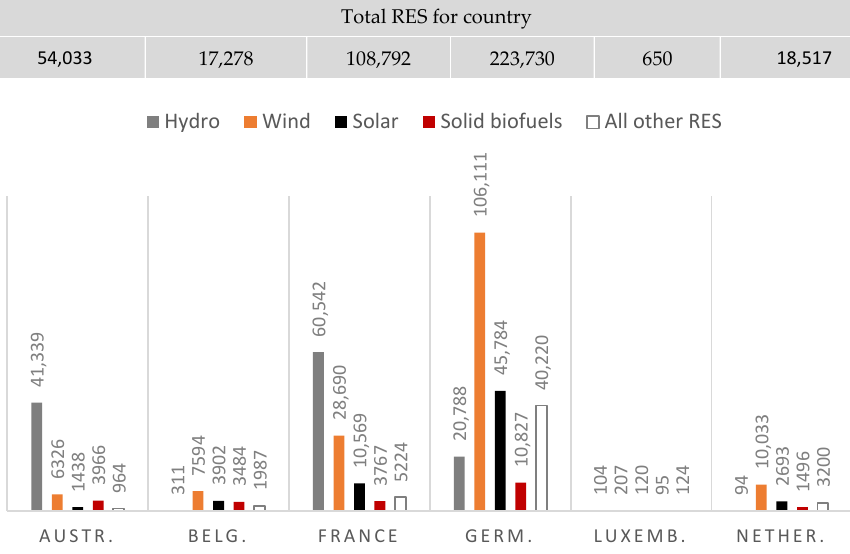
Figure 6. Types of RES (GWh) produced in 2018.